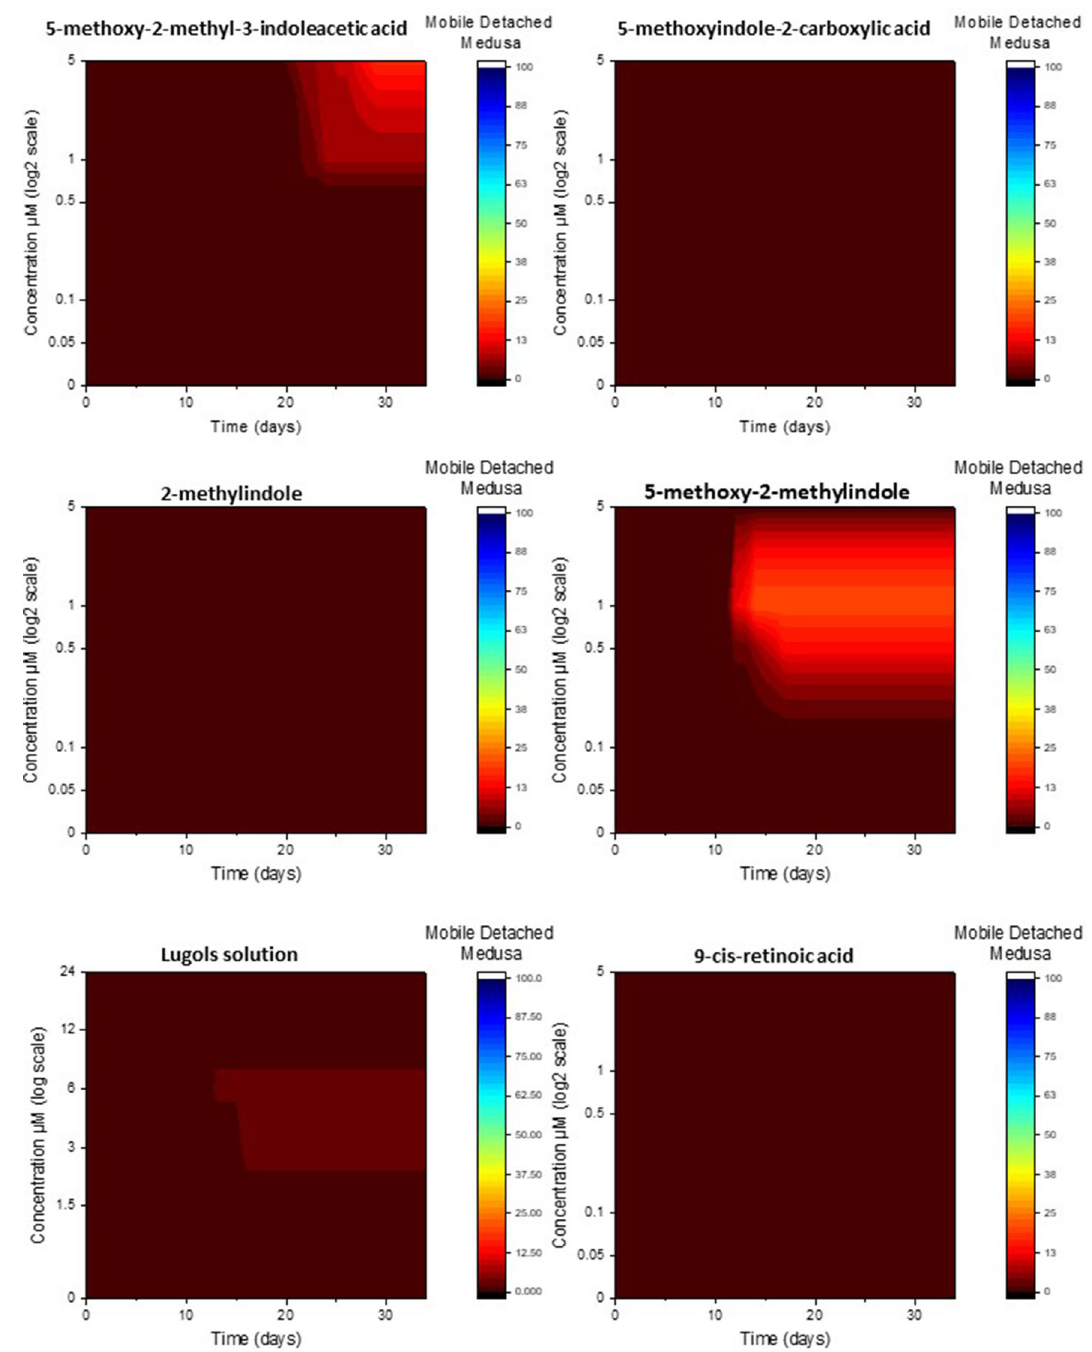
Figure 3. The cumulative percentage of Carukia barnesi polyps that detached healthy medusa after exposure to six chemical treatments, over time in response to chemical